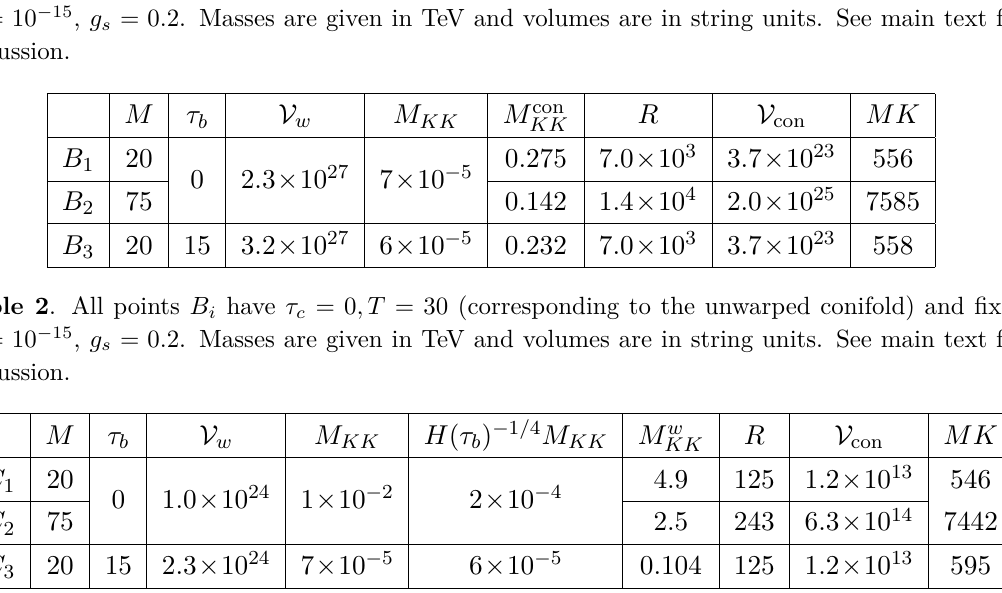
Table 3 . All points C i have τ c = 15 , T = 30 (corresponding a partially warped conifold) and fixed H = 10 − 15 , g s = 0 . 2 . See main text for